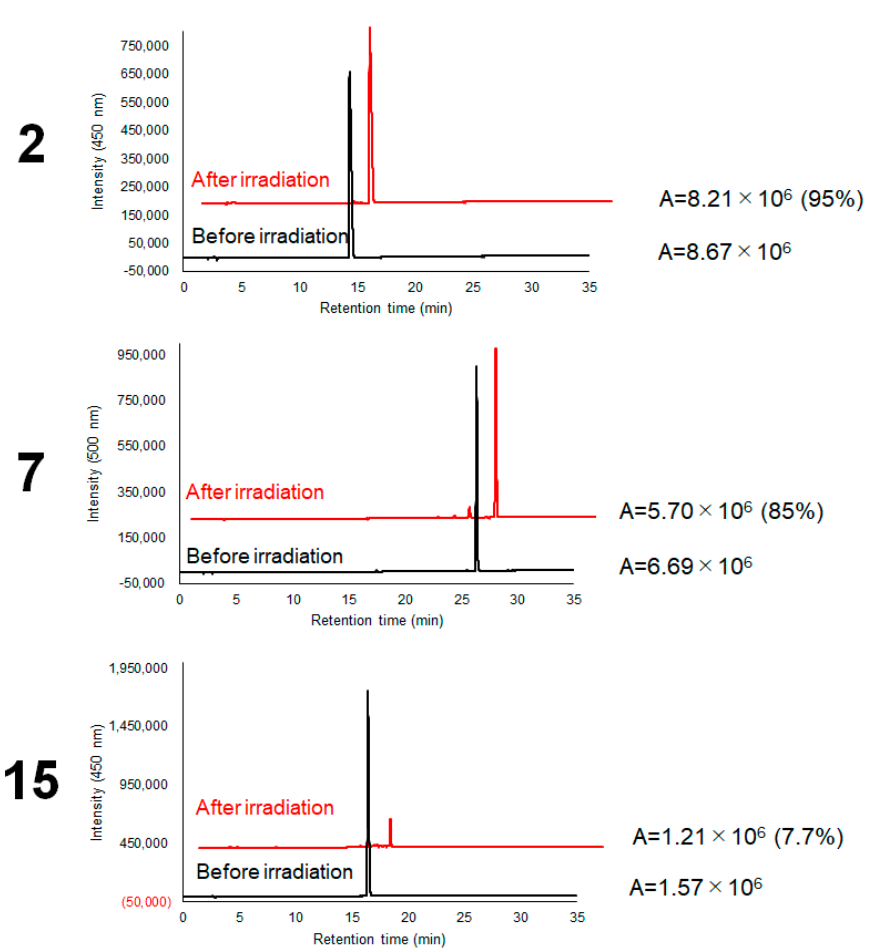
Figure 4. Photostability of 2 , 7 , and 15 .